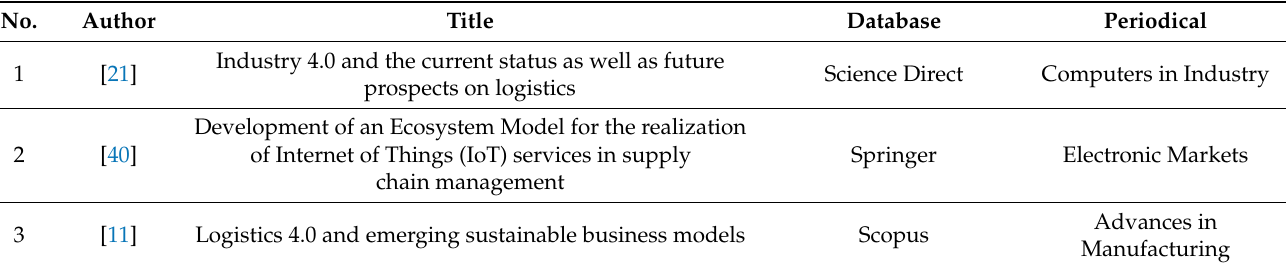
Table 2. List of articles included in the literature